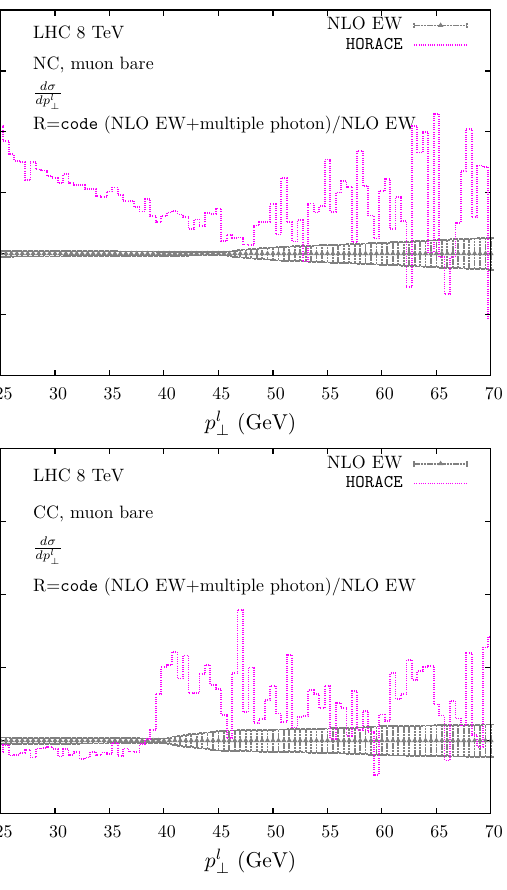
NC DY ( upper right ), lepton transverse momentum in CC DY ( lower left ), and lepton-pair transverse mass in CC DY ( lower right ) for the 8 TeV LHC with ATLAS/CMS cuts. The results are obtained in the HORACE formulation of matching NLO EW corrections to multiple- photon